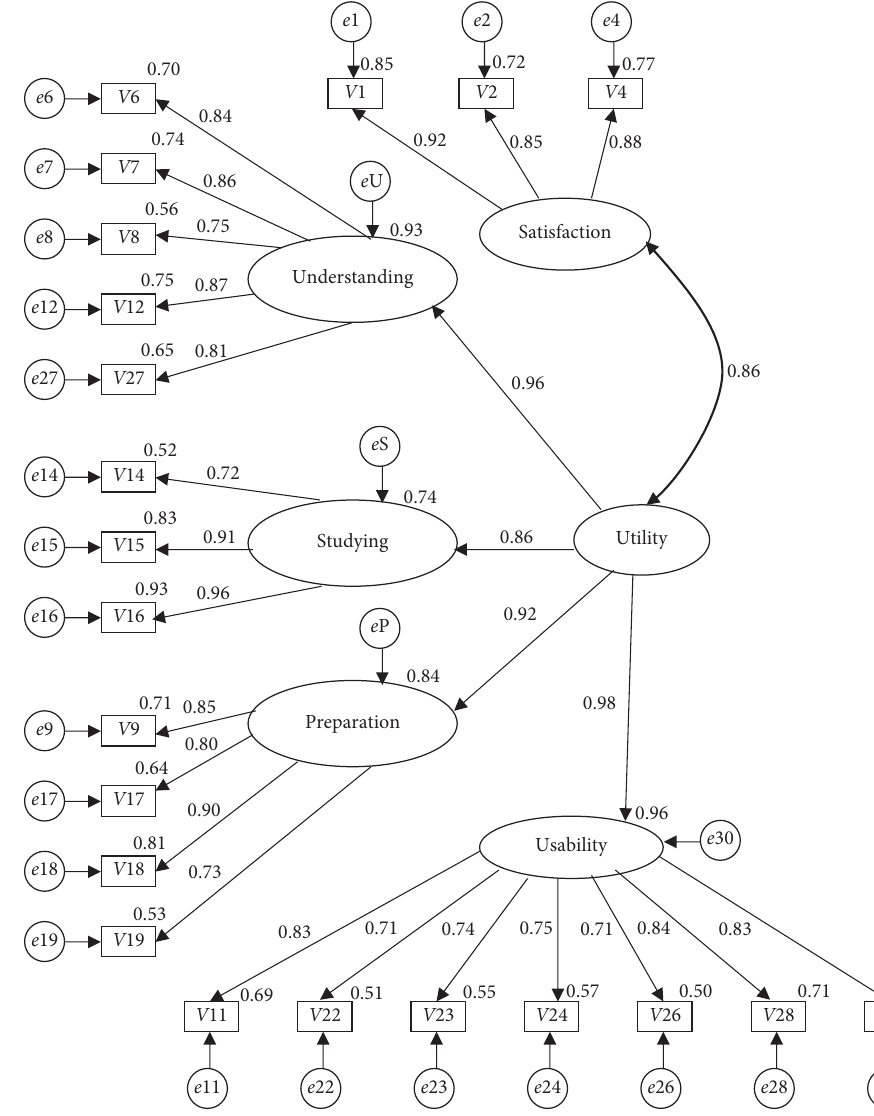
Figure 5: The final acceptable model loadings and explained variances. Table 7: Students’ satisfaction means and their significance